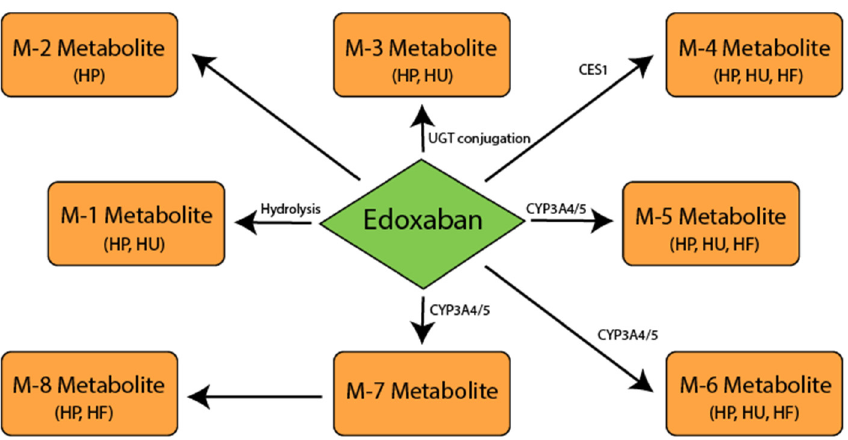
Figure 3. Postulated metabolic pathway for edoxaban. Carboxylesterase 1 (CES1); cytochrome P450 isoenzyme 3A4/5 (CYP3A4/5); human feces (HF); human plasma (HP); human urine (HU); metabolite (M); 5 ′ -diphospho-glucuronosyltransferase (UGT).